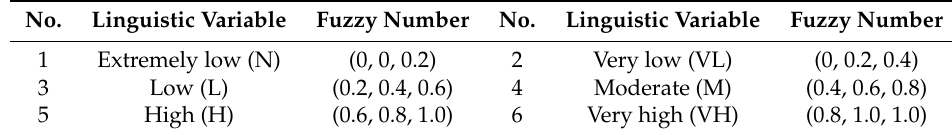
Table 2. The correspondence of linguistic terms and linguistic values.